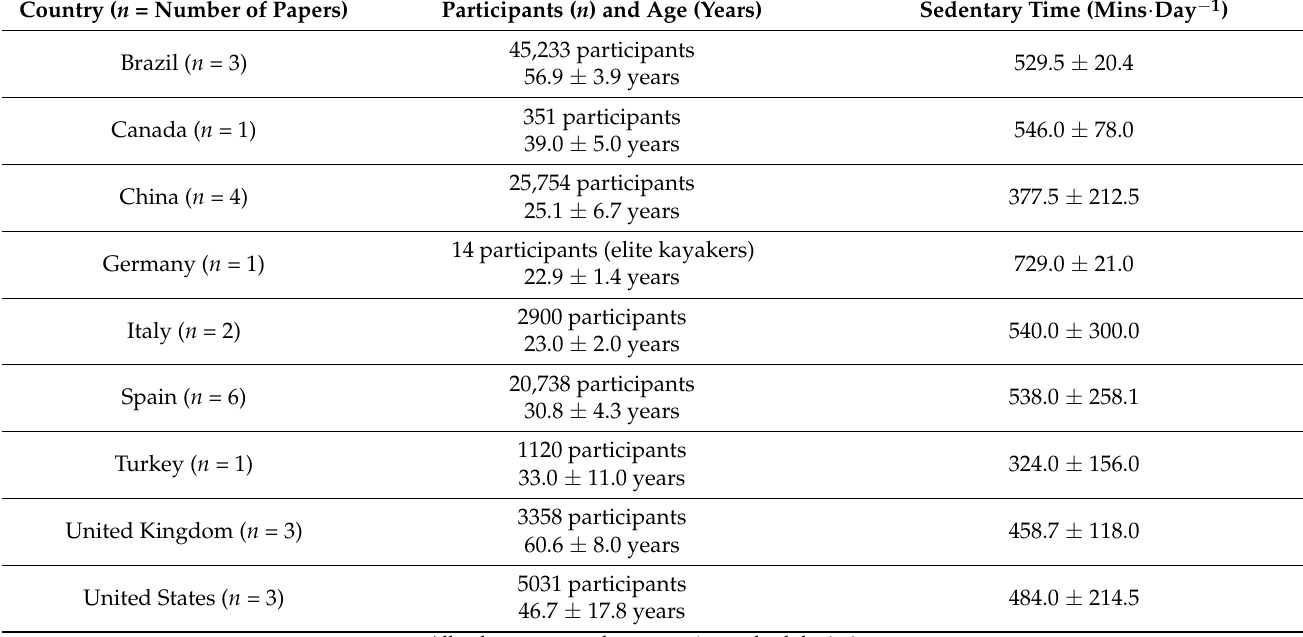
Table 4. Sedentary time of adults and older adults during the COVID-19 pandemic by country. Country ( n = Number of Papers) Participants ( n ) and Age (Years) Sedentary Time (Mins · Day − 1